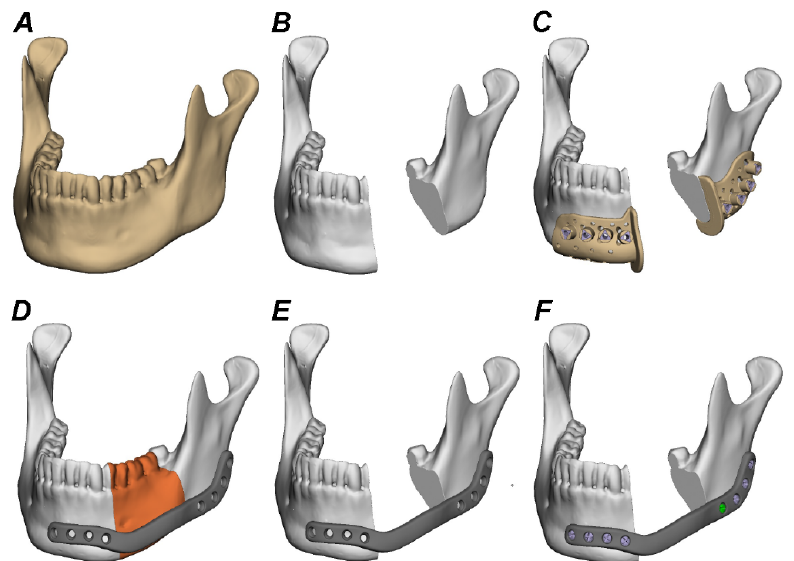
Figure 2. Segmentation, 3D reconstruction, and virtual planning of the mandibular defect size and plate design. ( A – C ), Digital image of the scanned polyurethane mandible before and after defining the defect size and planning the positioning of the resection guides. ( D – F ), Assessment of the ade ‐